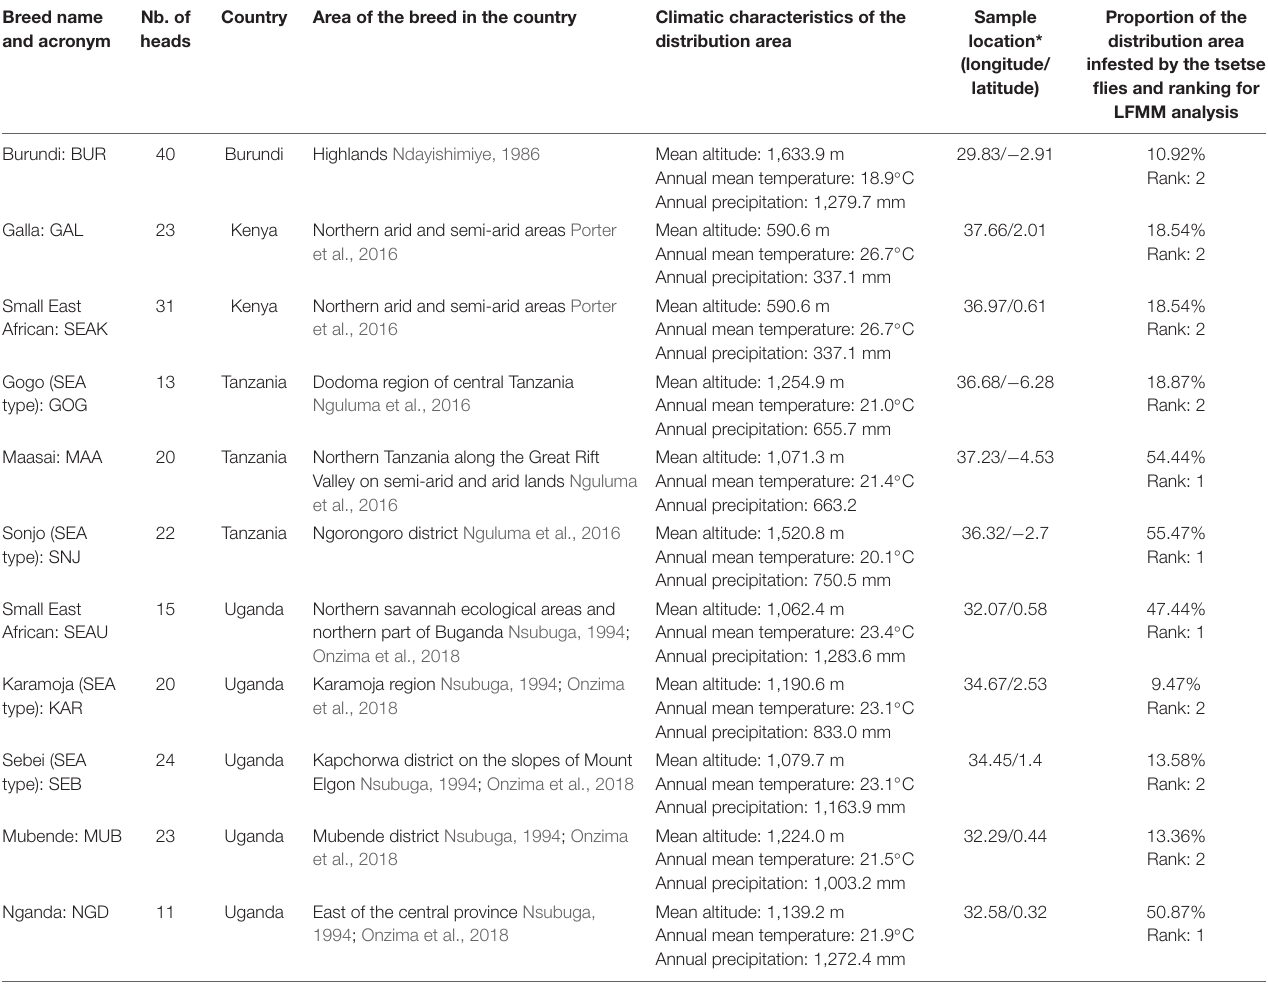
TABLE 2 | East African goat dataset. Breed name and acronym